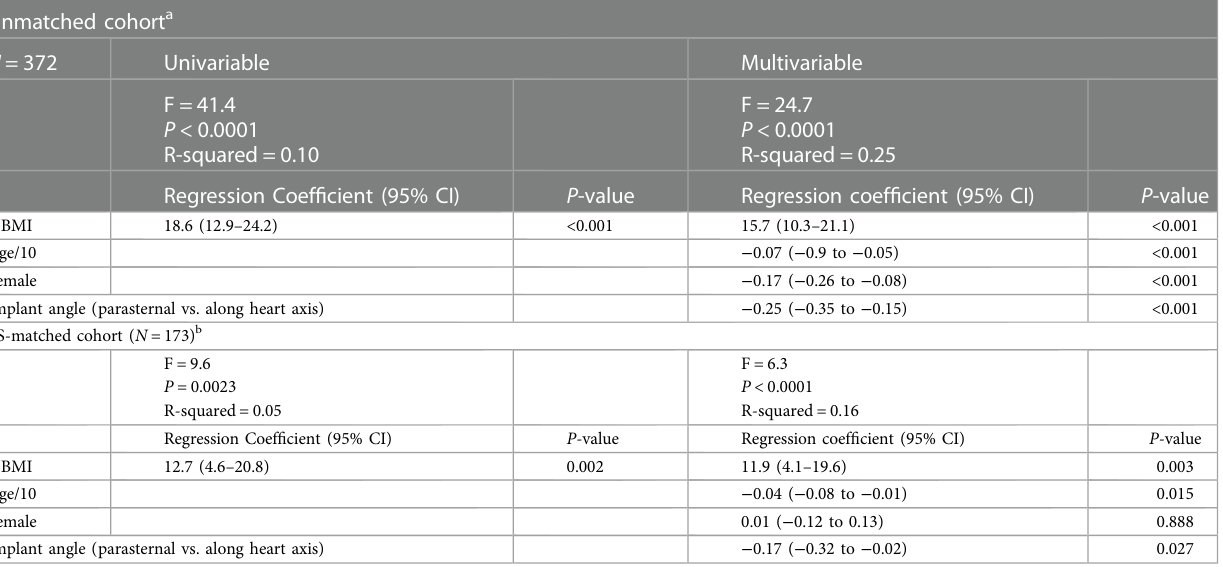
TABLE 2 Linear regression analysis of 3-month average R-wave amplitude vs.